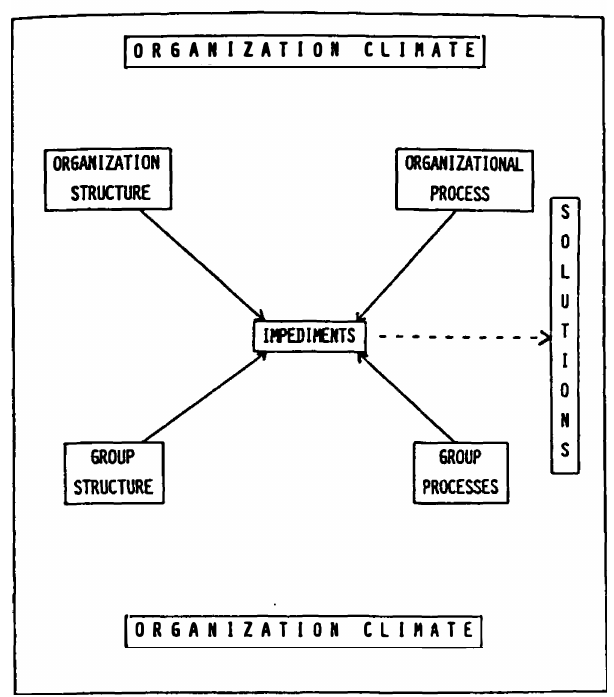
Figure I A model for formulating position papers MIITIC:1-ION IIATII 80r---------------,